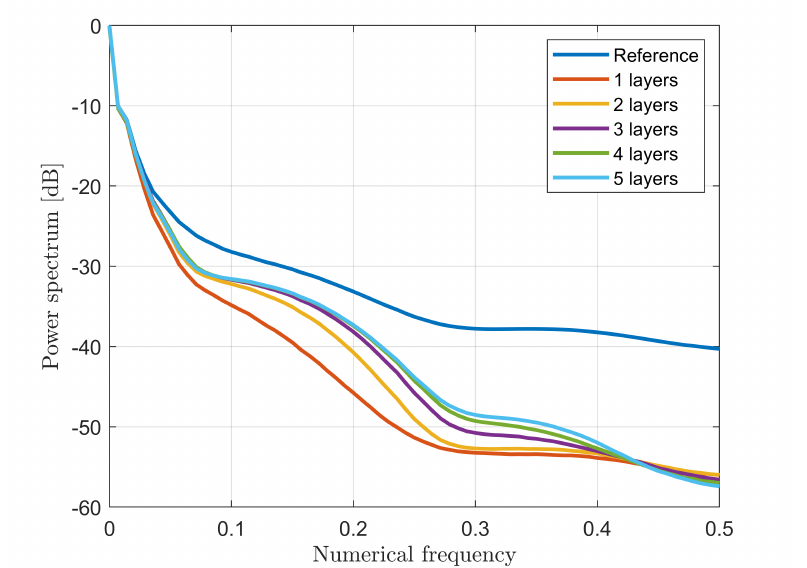
Figure 5. Averaged spectrum S ( ν ) for five different architectures with two-thousand nodes per layer as a function of the number of hidden